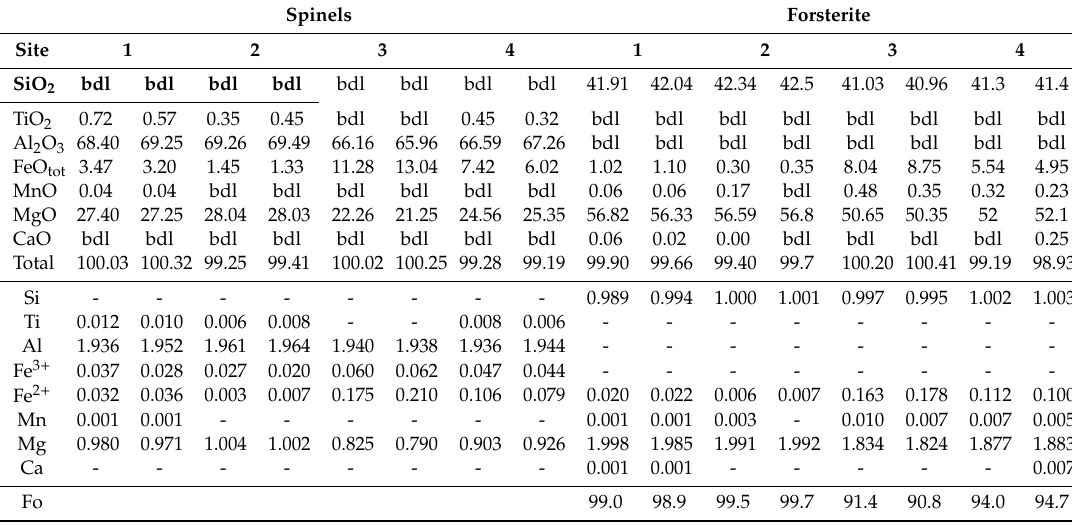
Table 1. Selected analyses of spinel and forsterite of the Tazheran Massif. Spinels Forsterite